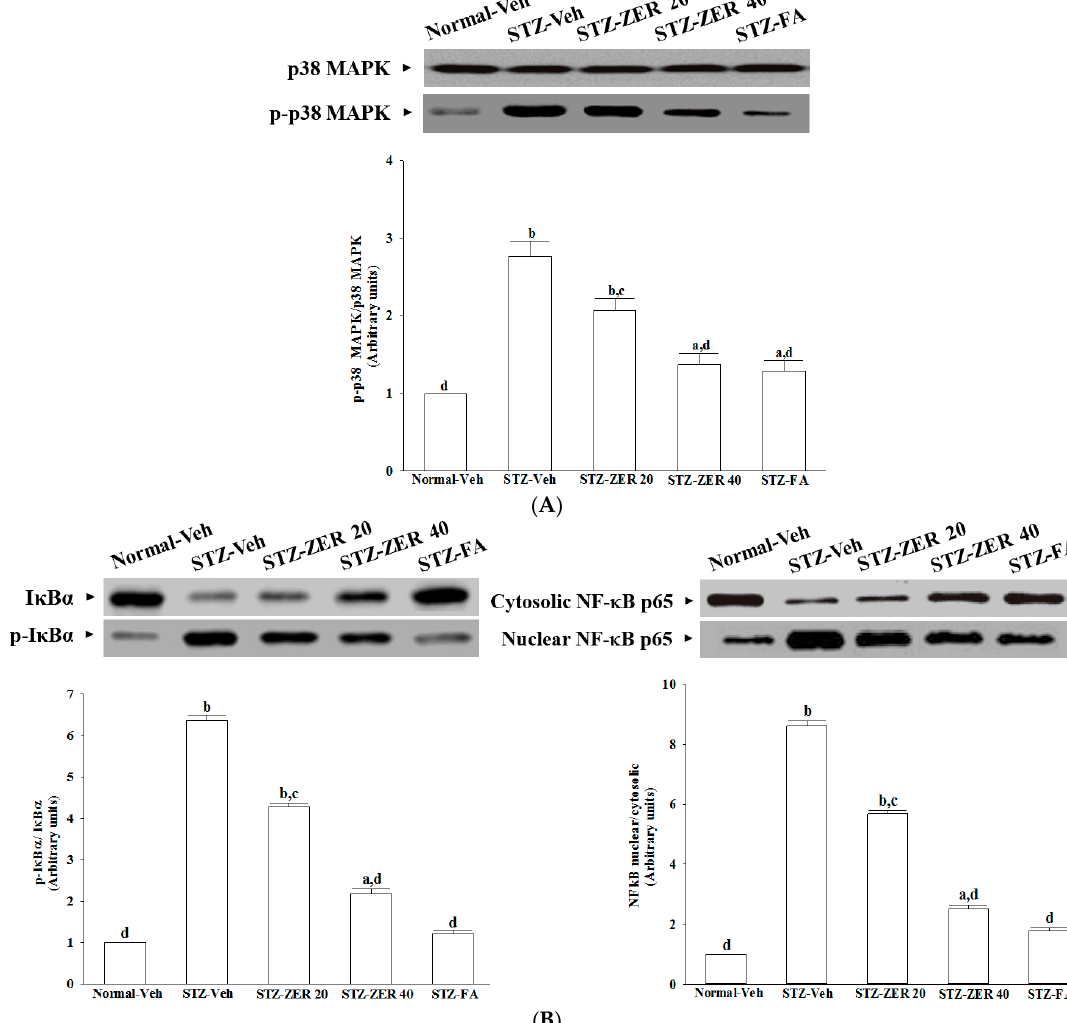
Figure 6. Effects on retinal p38 MAPK ( A ) and NF- κ B ( B ) activation. STZ-diabetic rats were administered 20 mg/kg/day zerumbone (STZ-ZER 20), 40 mg/kg/day zerumbone (STZ-ZER 40) or 100 mg/kg fenofibric acid (STZ-FA) by oral gavage once daily for three months. Another group of STZ-diabetic rats (STZ-Veh) and normal rats (Normal-Veh) were administered the same volume. The expression and phosporylation of retinal IkB protein have been indicated in left pannel on Figure 6B. NF- κ B p65 expression in nuclear and cytosolic fractions of retinas from rats has been shown in right pannel on Figure 6B. Data are mean ± SD from eight rats per group, and the experiments were repeated independently at least three times with similar results. a p < 0.05 and b p < 0.01 compared to vehicle-treated normal rats, respectively; c p < 0.05 and d p < 0.01 compared to the values of vehicle-treated STZ-diabetic rats, respectively.